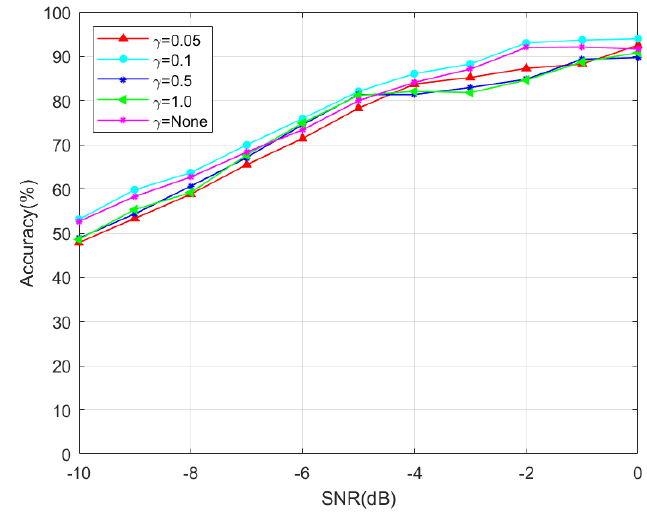
Figure 4. Classification performance of the CL − CNN model with different γ (the sample size per class is 55).